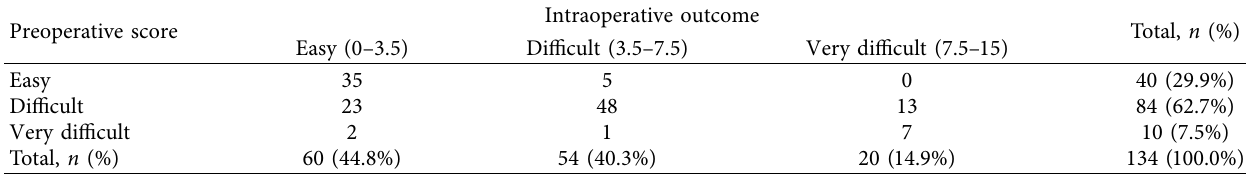
Table 6: Summary table of relationship analysis on intraoperative outcome with preoperative score category with chi-square. Preoperative